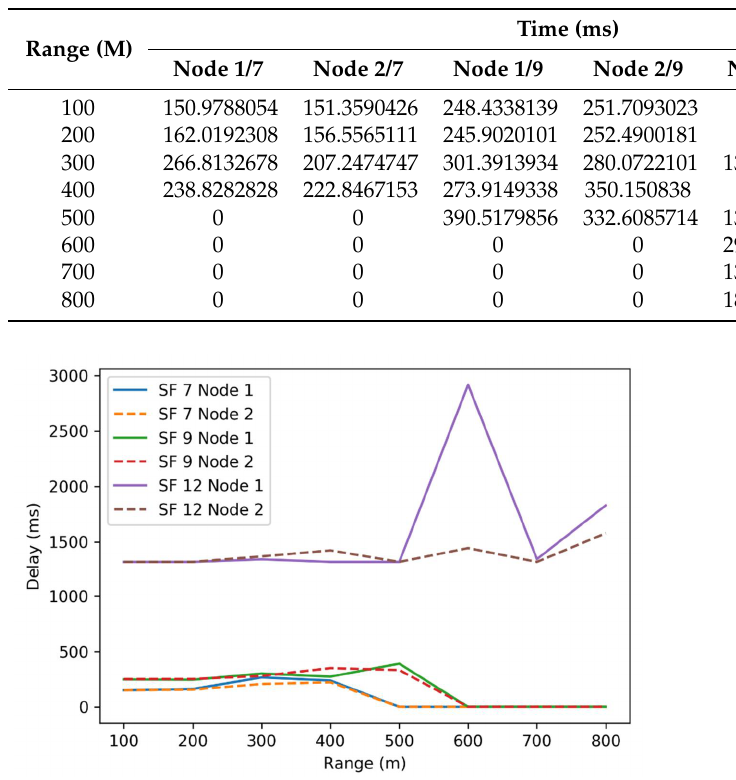
Table 4. The average value from reassessment of default parameters.